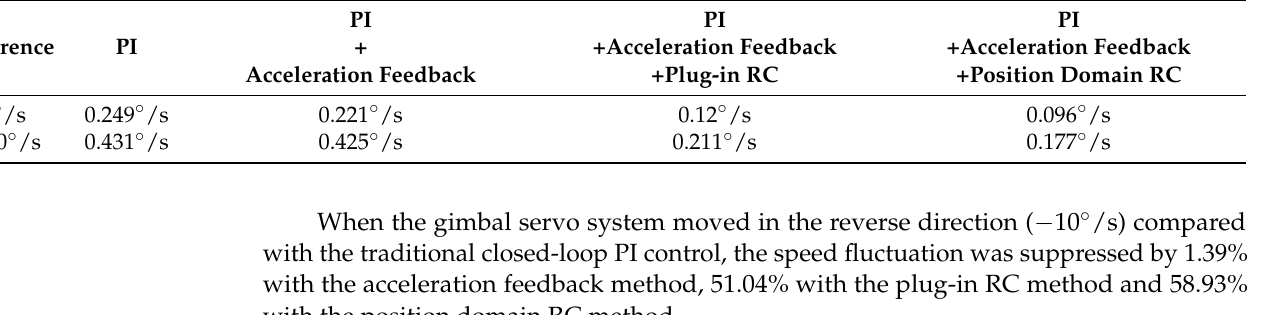
Figure 11. Simulation results of load angular speed curves at a steady speed motion. Table 4. Peak-to-peak comparisons of steady state with different control